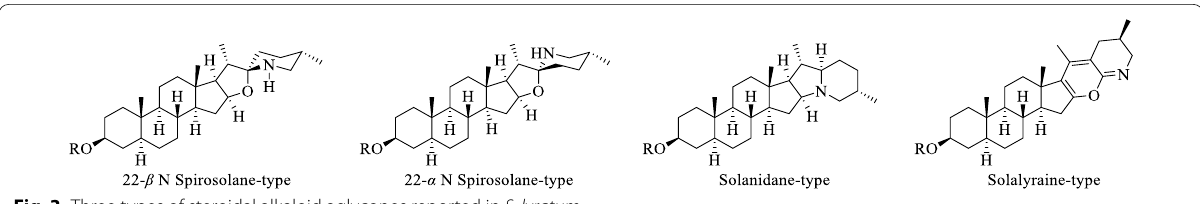
Fig. 3 Three types of steroidal alkaloid aglycones reported in S.